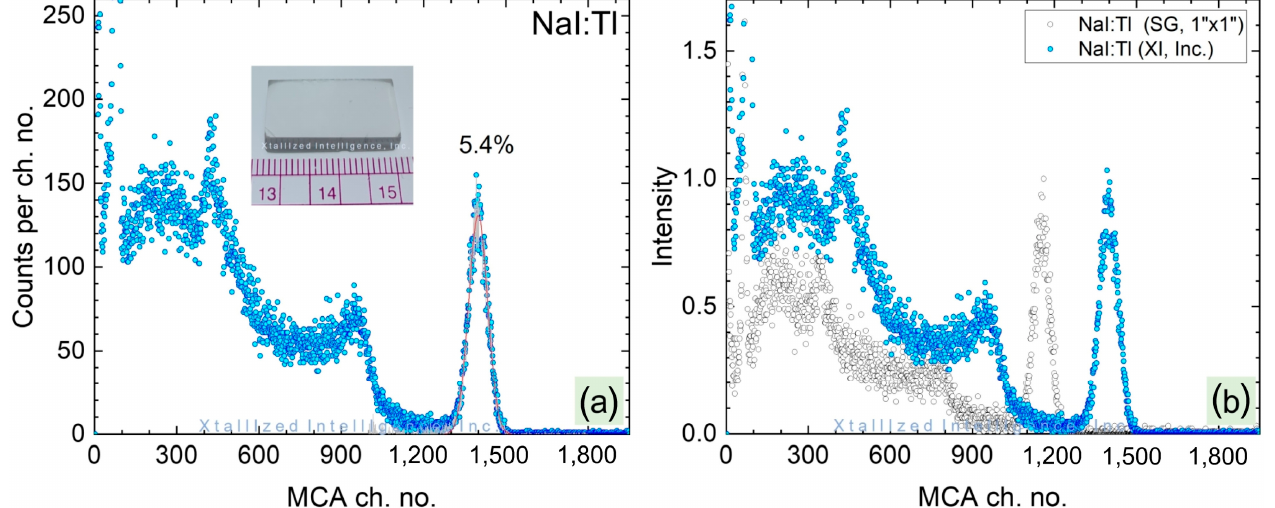
Figure 7. ( a ) 137 Cs spectrum collected with a NaI:Tl sample (inset) grown and processed by XI, Inc.